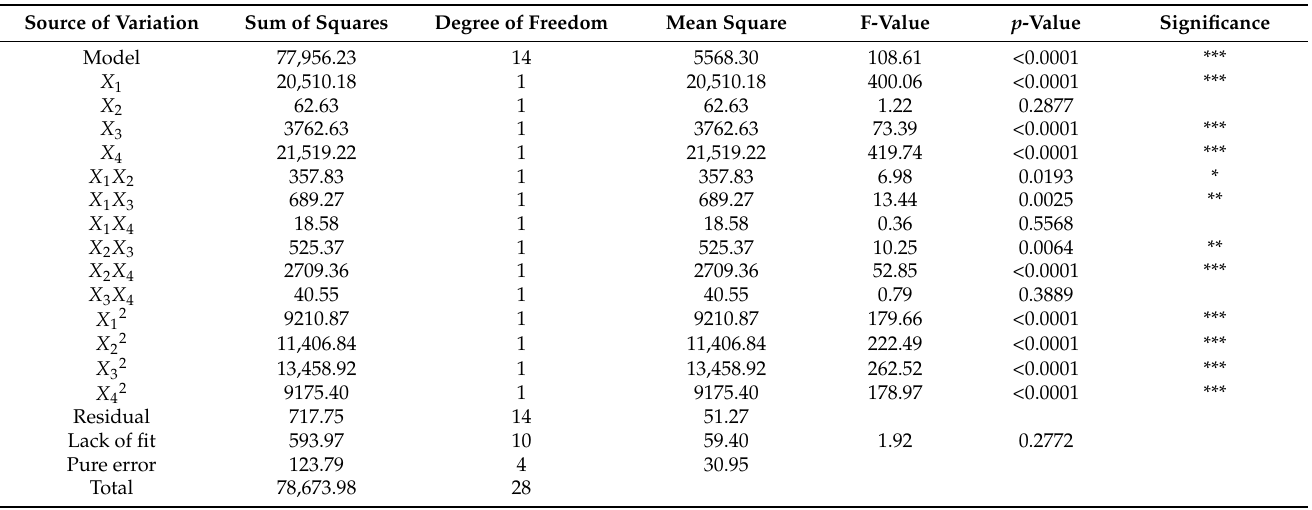
Table 4. ANOVA of regression